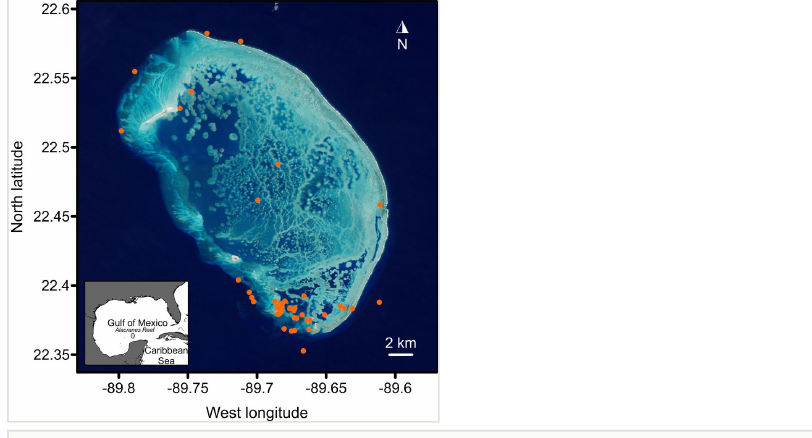
Figure 1. Location of sampling points in the Alacranes Reef National Park. The image from the NASA Earth Observatory, was acquired by Jesse Allen on November 5, 2014, by the Operation Land Imager on Landsat